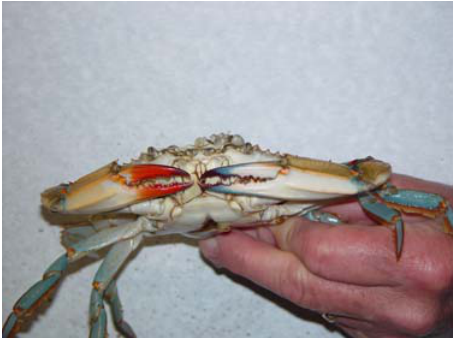
Figure 7. Anterior view of the gynandromorph blue crab. This an anterior photograph of the gynandromorph blue crab with the red clawed female side and the blue clawed male side.